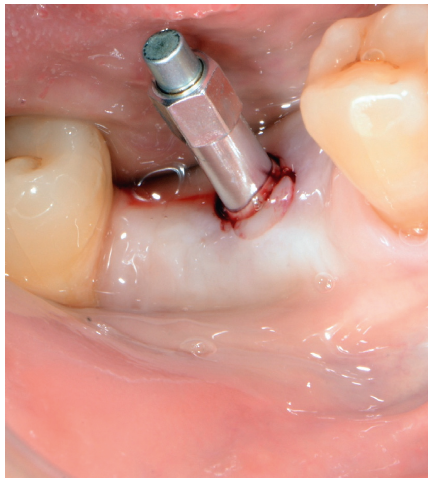
Figure 10: ISQ measurement at uncovering of the implant.